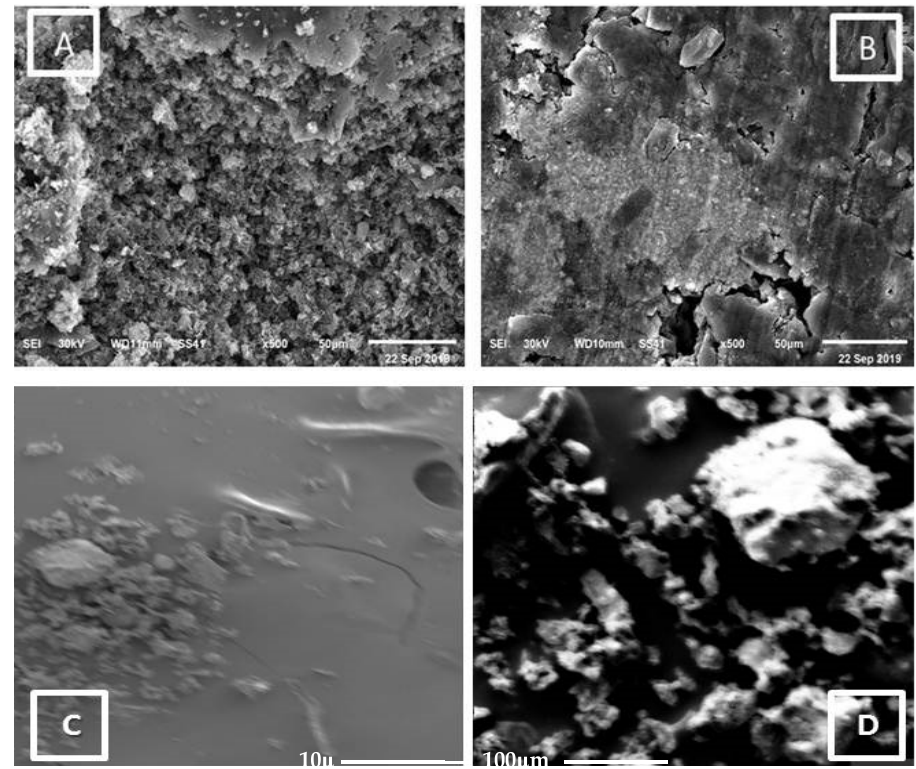
Figure 4. ( A – D ). SEM image of the [Se(Folic)(Chitosan)] complex. ( A ) Small attached amorphous granules; ( B ) Coarse surface with a disparate; ( C ) Tuft-like and aggregated pored structure ( D ); and straight and pointed particles.